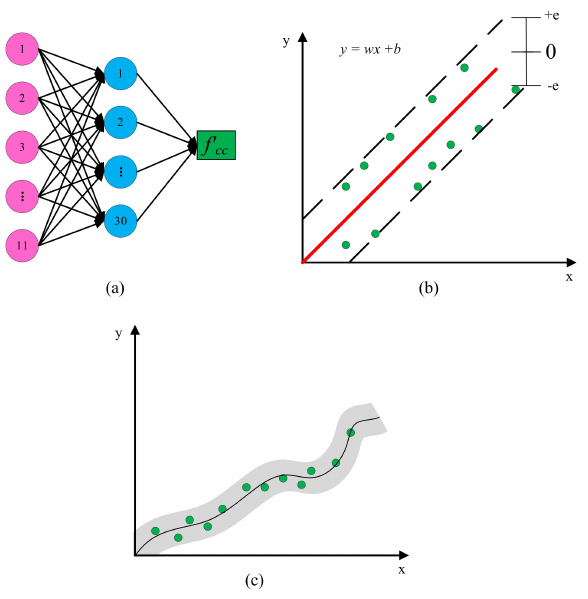
Figure 4. Architecture of ML models ( a ) ANN, ( b ) GPR, ( c )